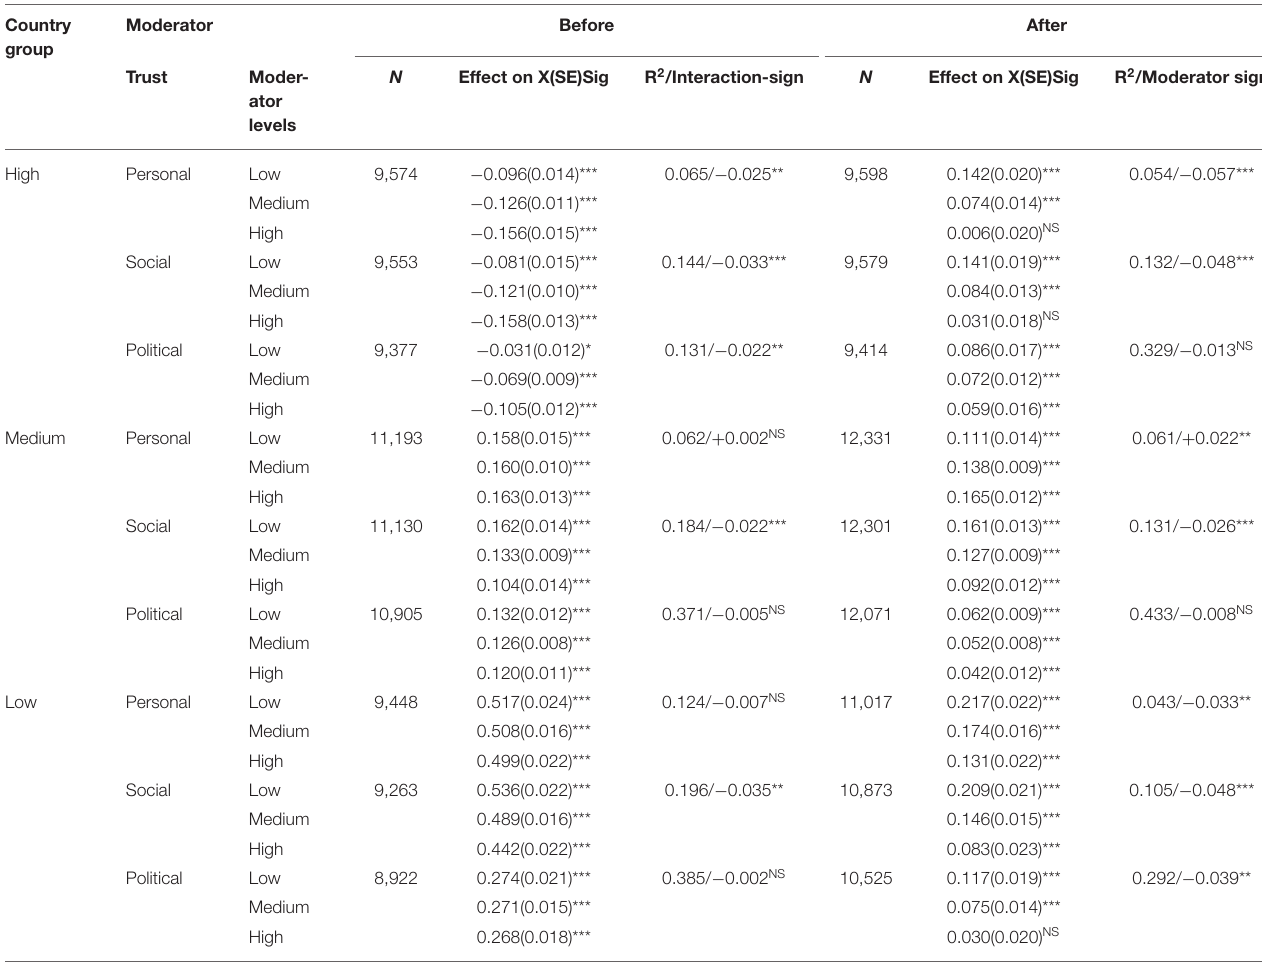
TABLE 6 | Results of analysis for the moderator role of personal, social, and political trust for X = national income and Y = political satisfaction, separated by before and after the financial crisis of 2008/2009 and country group as defined by overall trust. Country